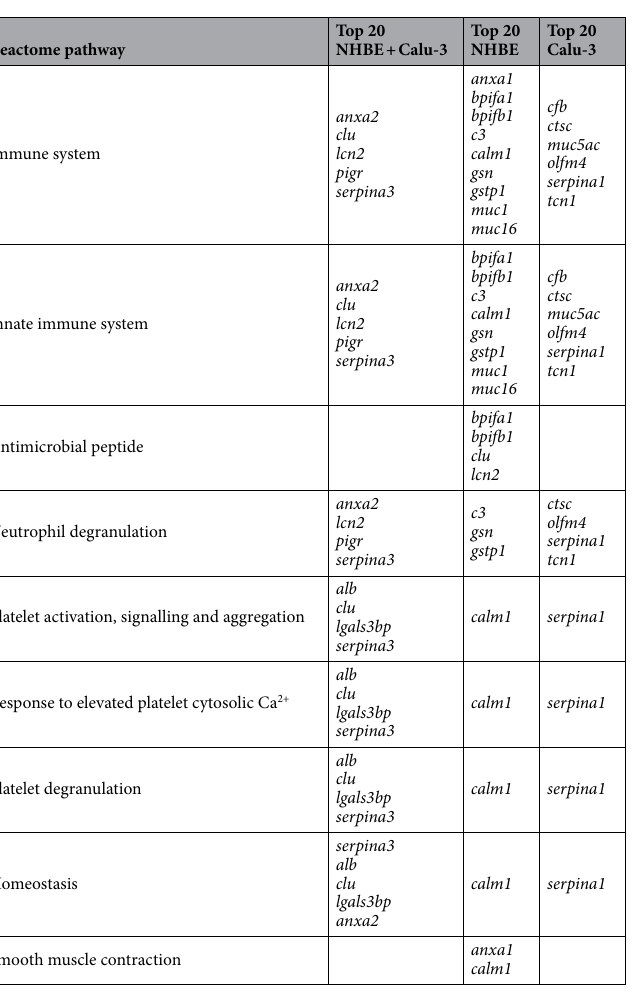
Table 1. List of the biological pathways and their associated proteins identified in the secretome of NHBE and/or Calu-3 cells at day 11–12 and 18 after ALI. Only the 20 most abundant proteins were considered. Proteins are designated by their corresponding gene. The description of each protein is given in Table